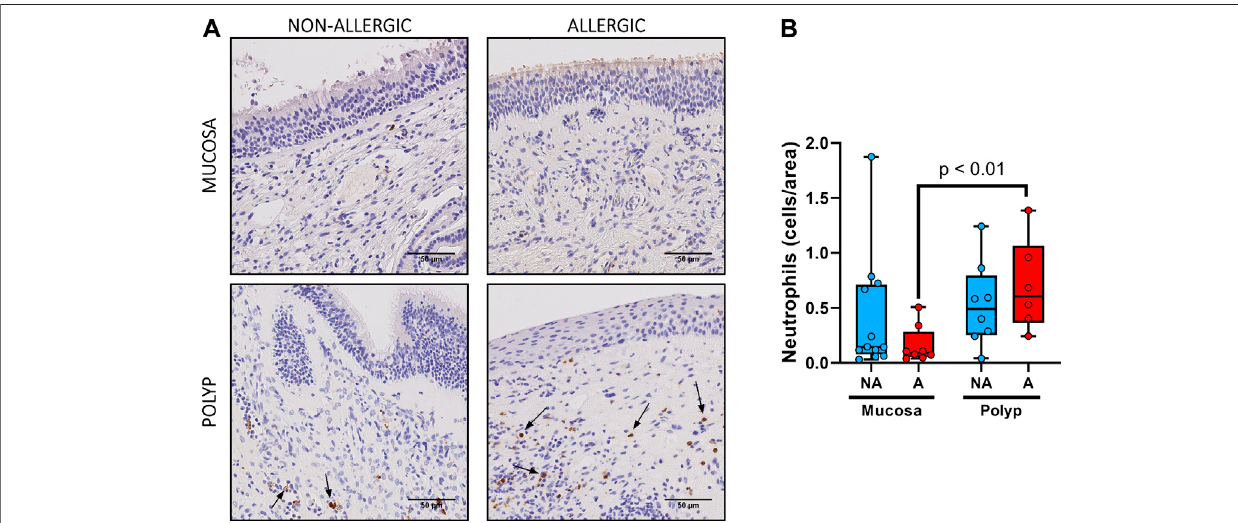
FIGURE 5 | Analysis of neutrophil in fi ltrates in nasal polyps and nasal mucosa. (A). Representative images of anti-neutrophil elastase immunostaining in nasal mucosa ( n (cid:2) 20) and nasal polyps ( n (cid:2) 14) in all experimental groups (neutrophils: black arrow → , scale bar (cid:2) 50 μ m). (B). Comparison of the number of eosinophils per area in nasal polyps and nasal mucosa samples between non-allergic CRSwNP (NA) and allergic CRSwNP (A) patients. Results are presented as mean ± SEM. Mann- Whitney U test was used to state signi fi cant differences.